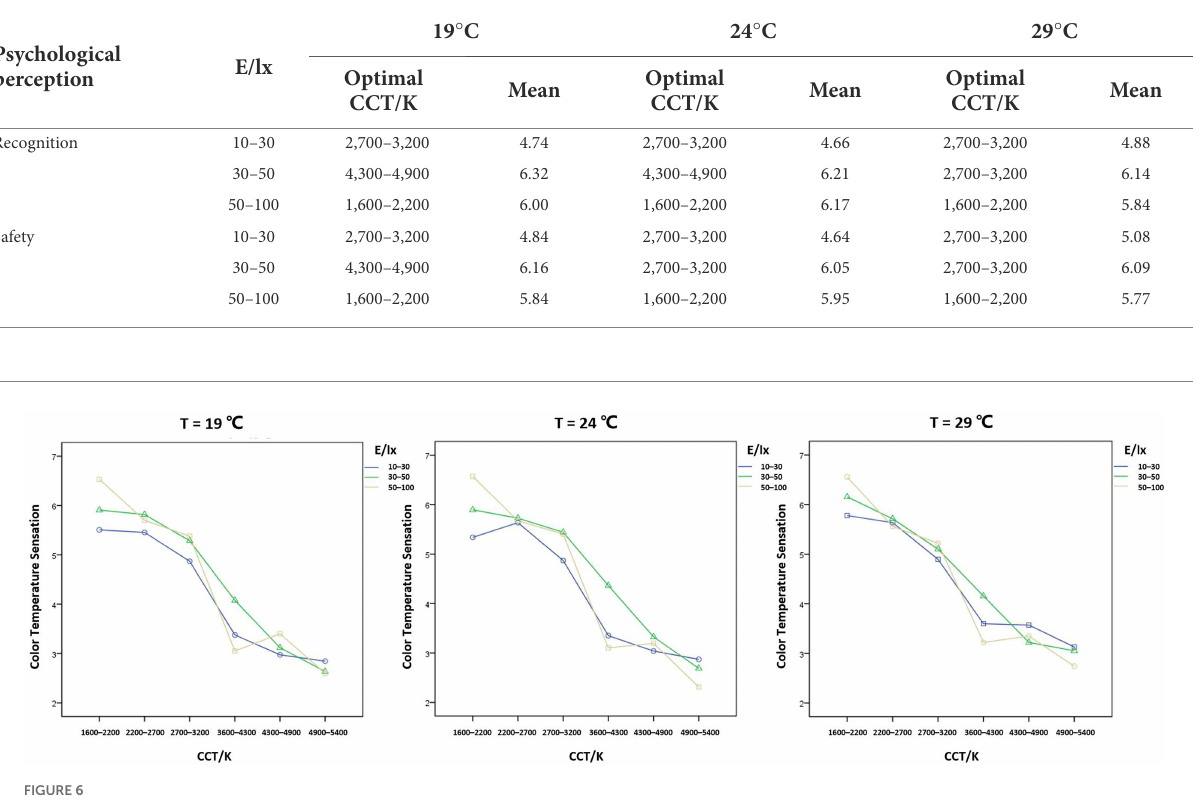
(Figure 6), F = 38.264, p = 0.005 < 0.05. Therefore, a simple